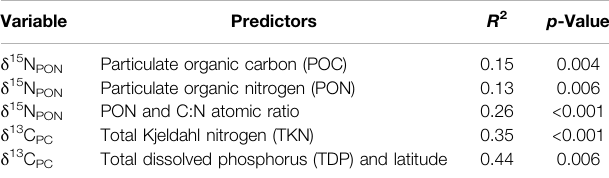
TABLE 1 | Redundancy analysis and best subsets regression analysis